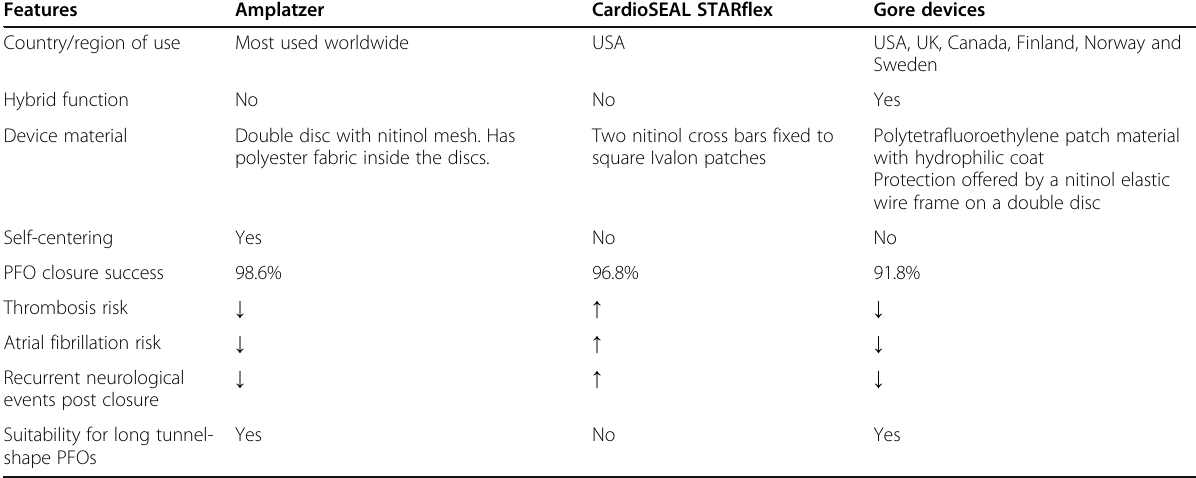
Table 2 Comparison of common PFO closure devices [3, 4, 32]